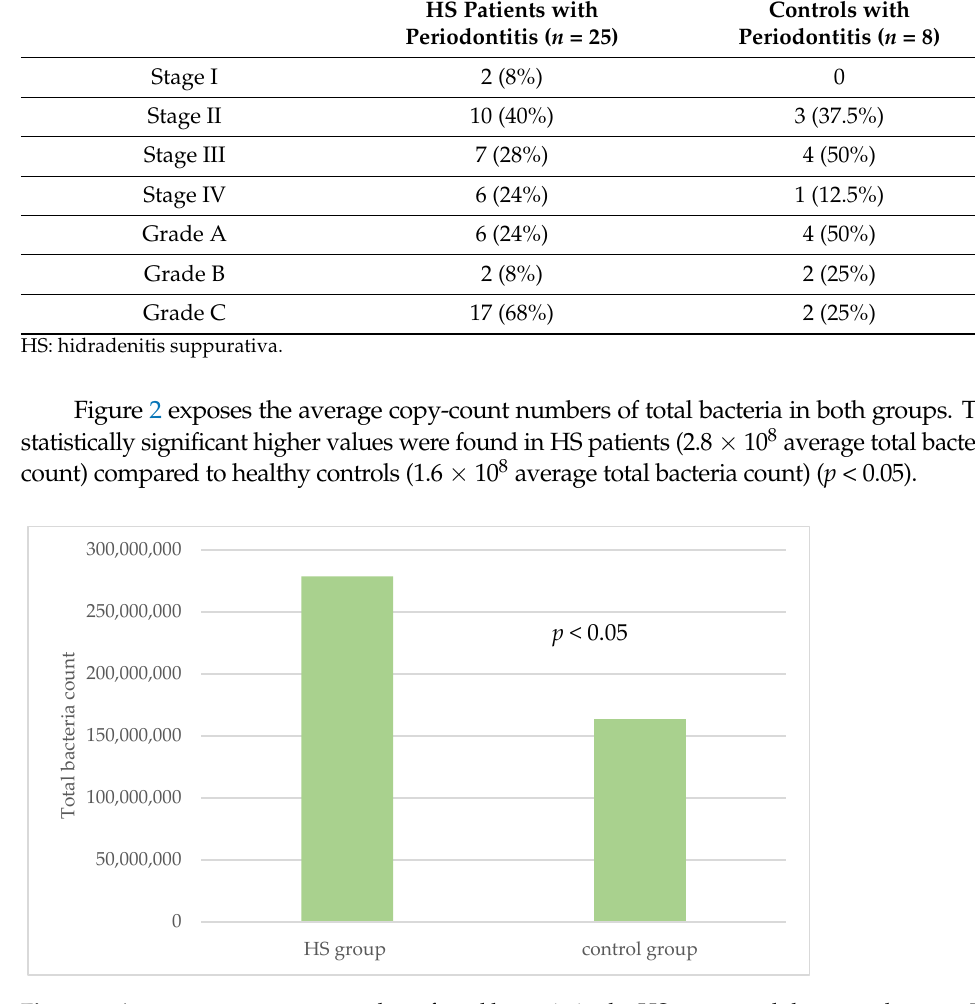
Table 3. Comparison of the copy number of pathogens collected from gingival sulci and the per ‐ centage of patients with particular bacteria in the HS group and the control group. Mean ± SD